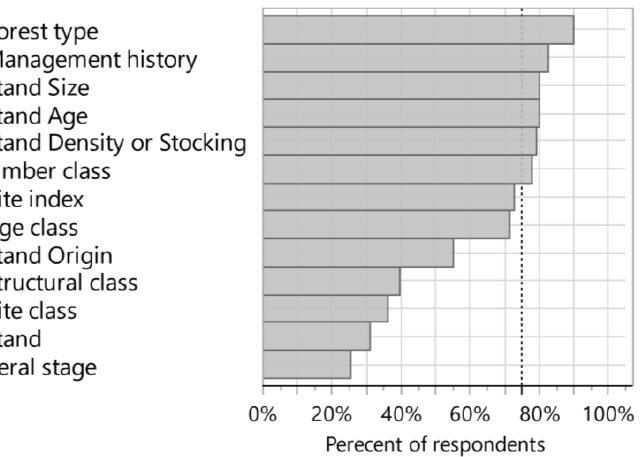
Figure 4. Stand-level variables for which forest managers would like information from wildlife scientists. Dotted line represents 75% of survey respondents.